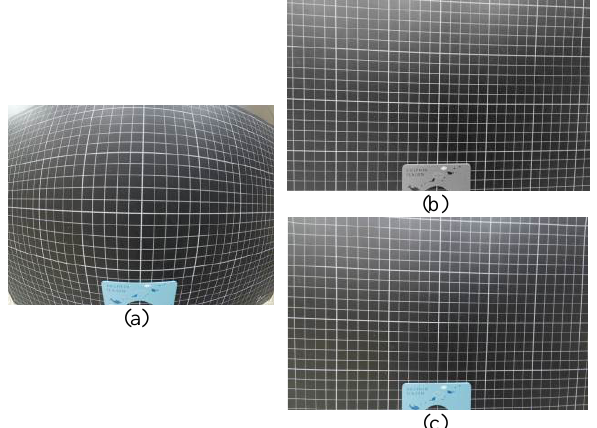
Figure 4. Original and undistorted images: (a) original image; (b) undistorted image using Photomodeler parameters; (c) undistorted image using Photoscan